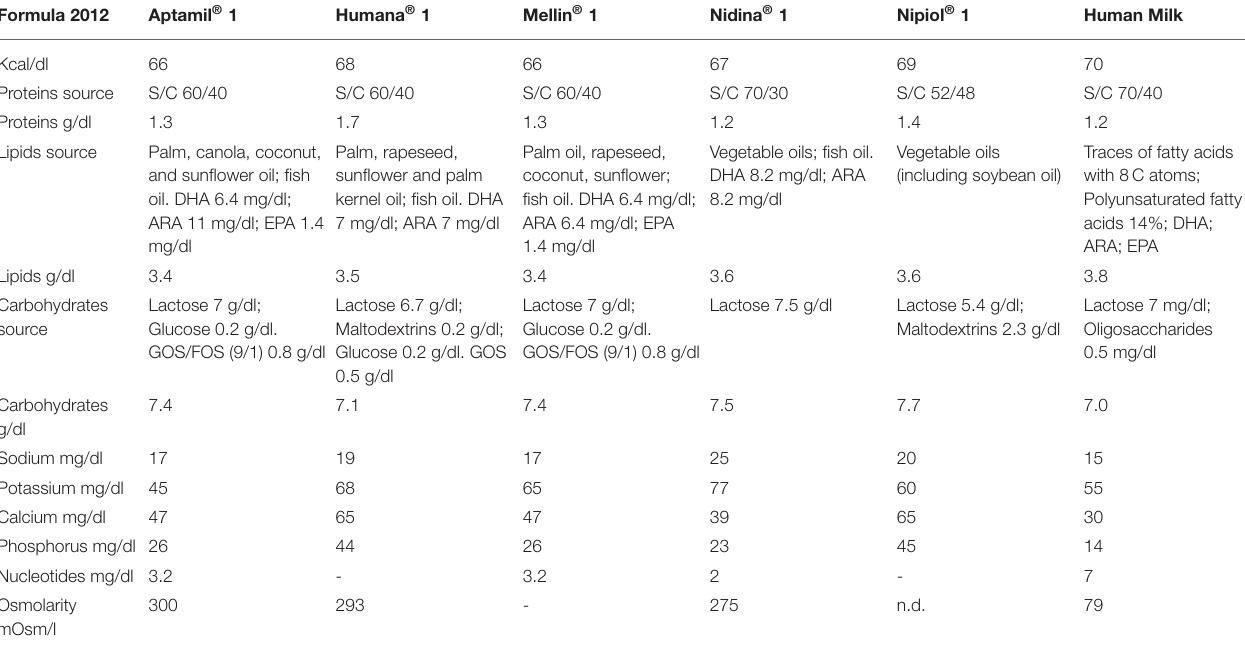
TABLE 1 | Comparison between breast milk and infant formula on the market in Italy around 2008, in the period in which the patients in the study were infants. Formula